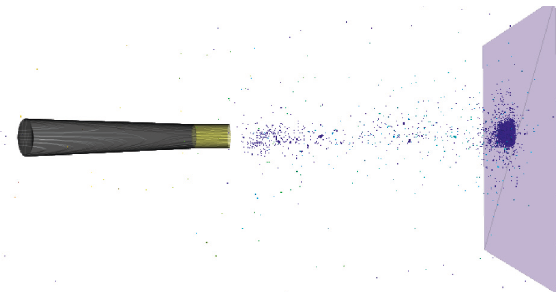
Figure 9: Numerical simulation experiment process. Table 5: Numerical simulation experimental